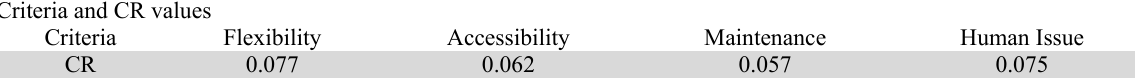
Criteria and CR values Criteria